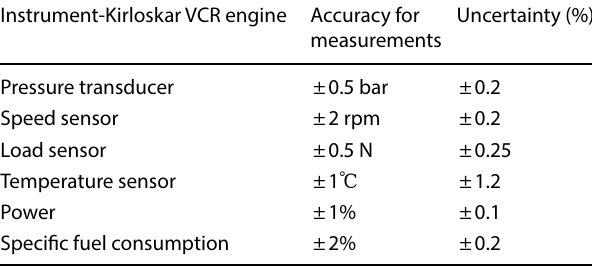
Table 5 The summary of accuracy ranges for the measurements taken on VCR engine Instrument-Kirloskar VCR engine Accuracy for